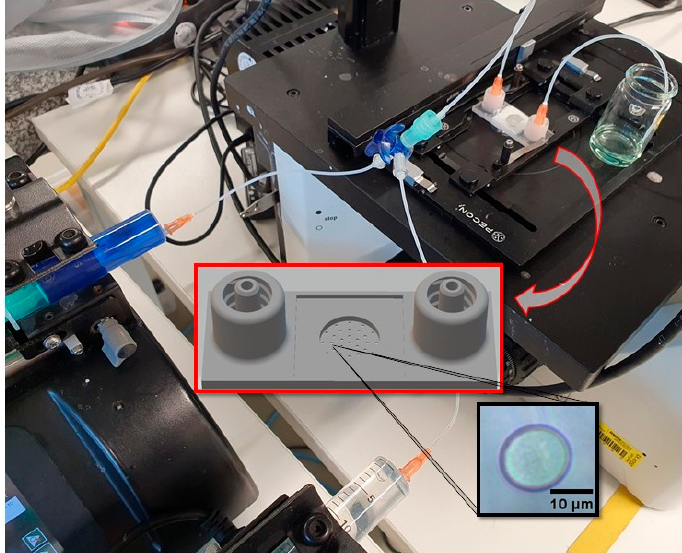
Figure 1. Experimental set-up consisting of inverted microscope with video monitoring, microfluidic swelling cell, syringe pumps for the repeated swelling cycle—experiments.